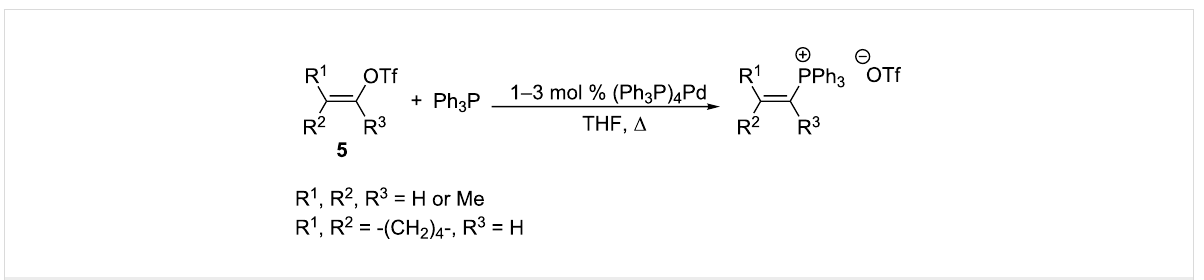
Scheme 6: Alkylation of triphenylphosphine with vinyl triflates in the presence of (Ph 3 P) 4 Pd.